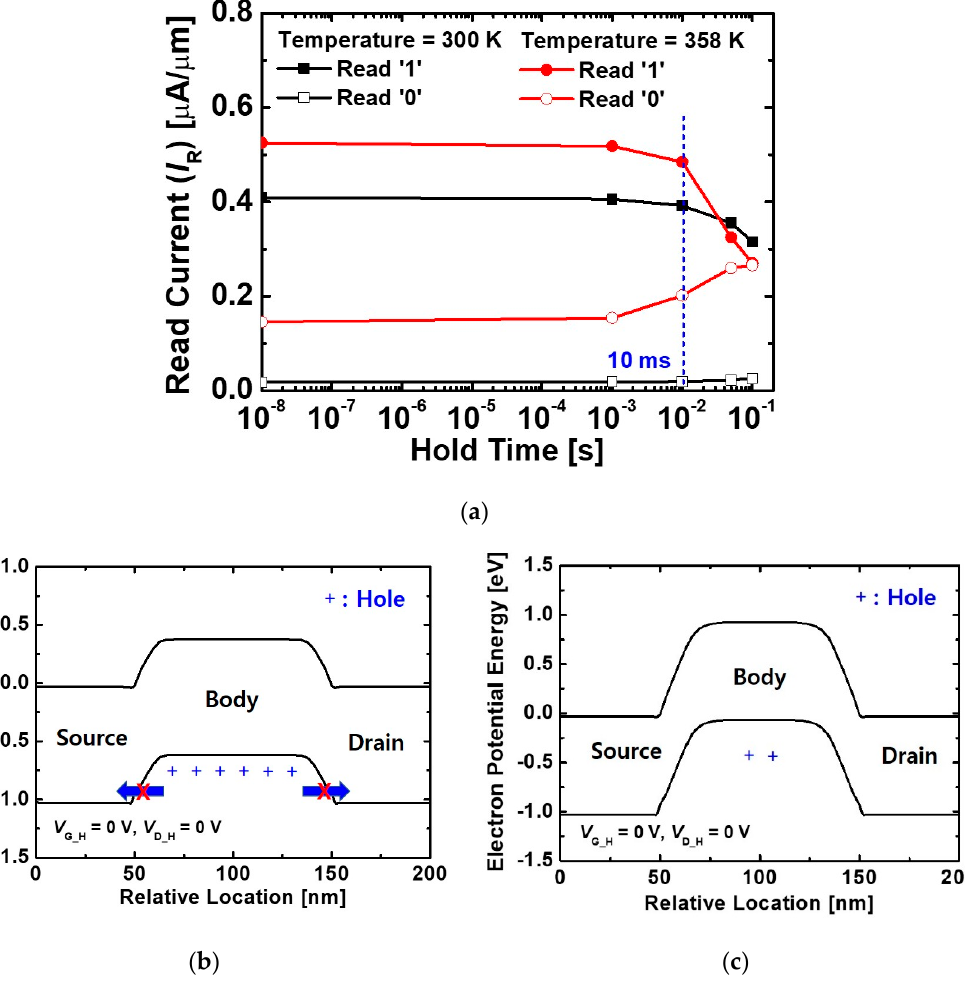
Figure 8. ( a ) Read currents I R1 and I R0 as functions of hold time at the temperatures of 300 K and 358 K. ( b ) The energy band diagrams for the hold operation at ( b ) ‘1’ and ( c ) ‘0’ states are also provided. The V G_H and V D_H are both at 0 V.